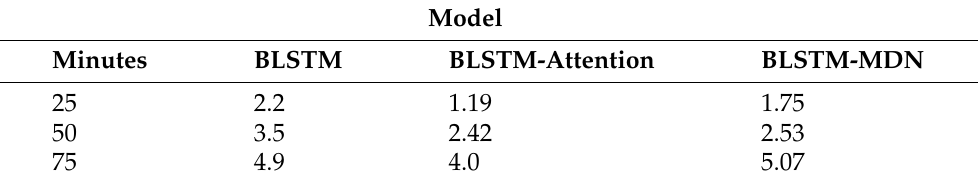
Table 4. Comparison of the BLSTM Mixture Density Network (BLSTM-MDN) model with a BLSTM model and a BLSTM model with a 2-headed Self-attention mechanism. The distance errors are calculated in kilometers as the mean of all the errors at a specific time step using the Haversine distance